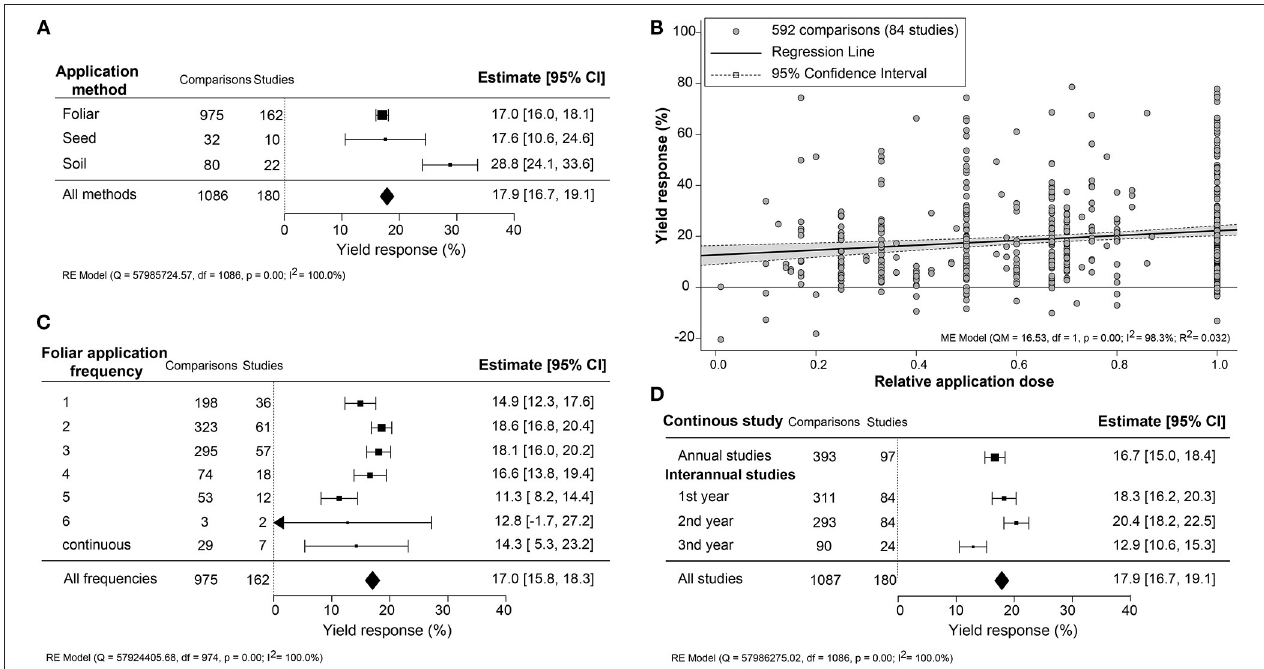
FIGURE 3 | Percentage yield response to biostimulant application affected by the different application management practices, including (A) application method, (B) frequency, (C) concentration, and (D) interannual studies. The point size correlates to the estimate’s precision, and the error bars represent 95% confidence intervals (CI) of mean estimated effect sizes. The number of comparisons and studies is indicated in each line or legend. The combined effect estimates and the test of heterogeneity on the models [random-effect models (RE) in (A,B,D) , and mixed-effect model (ME) in (C) ] were summarized at the bottom, where the heterogeneity